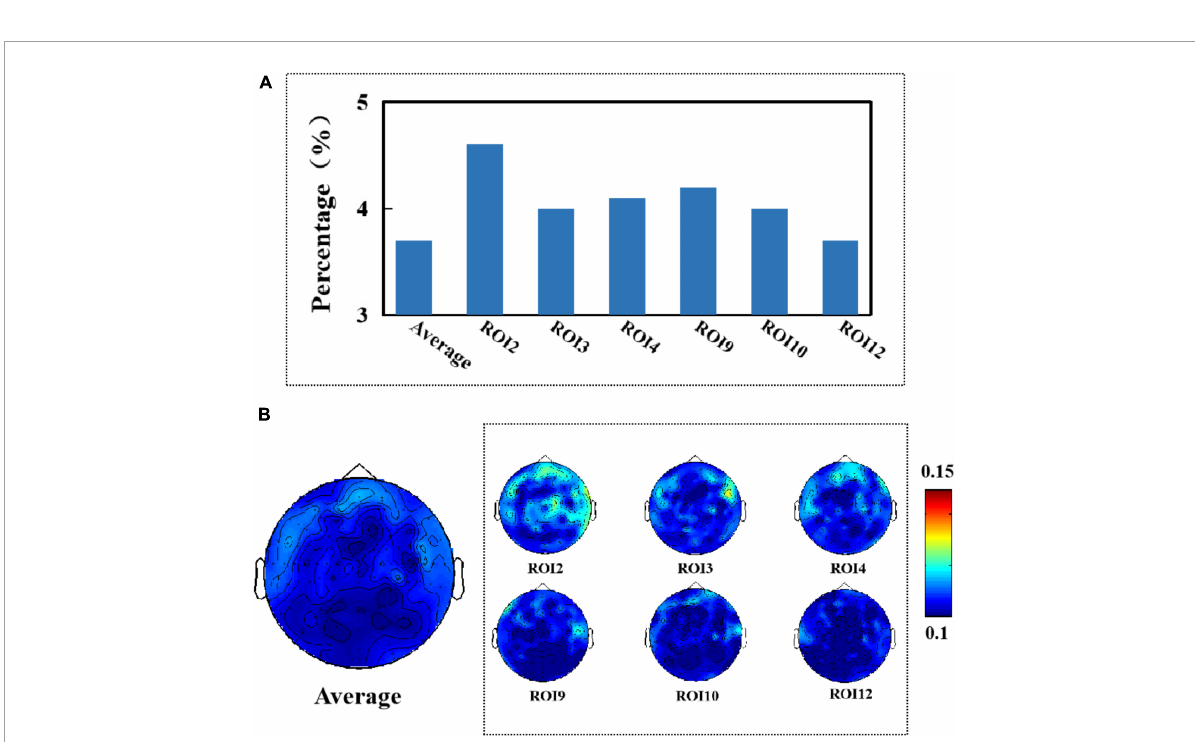
FIGURE7 (A) Average percentage of significant causal relationships of facial ROIs for different electroencephalography (EEG) signals. (B) Topography of affected brain regions (artifact